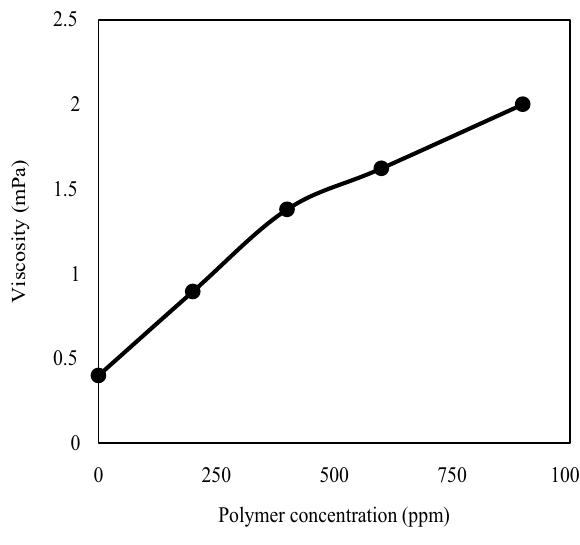
Fig. 5 The effect of polymer concentration on emulsion viscosity